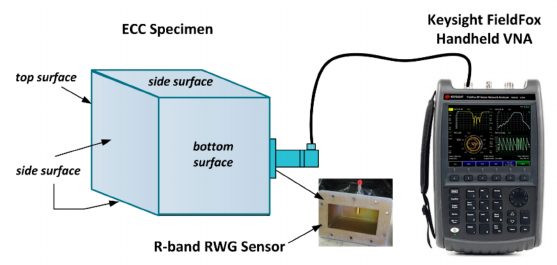
Figure 2. Schematic of nondestructive microwave measurement